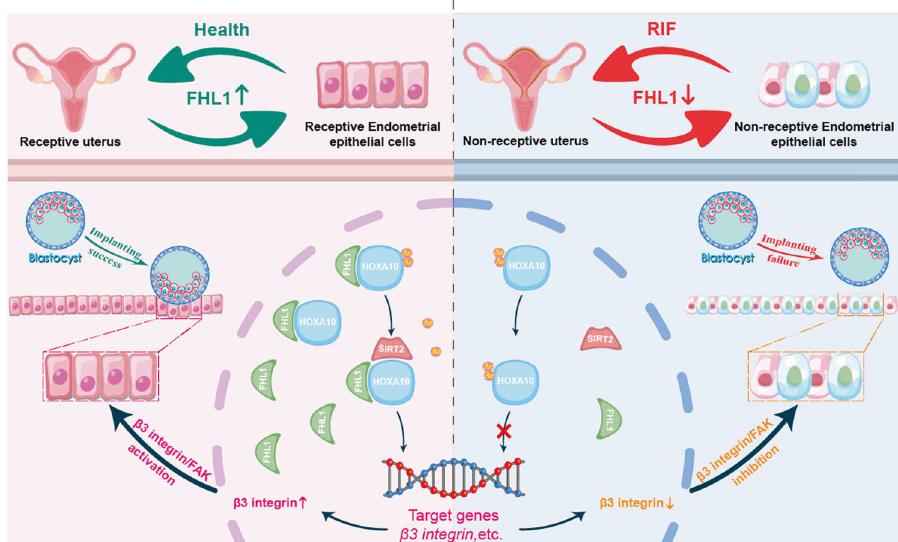
Fig. 8 Schematic diagram of the role of FHL1-mediated HOXA10 deacetylation in the regulation of blastocyst epithelial adhesion in RIF patients and fertile controls. In endometrial epithelial cells, FHL1 increases HOXA10 deacetylation by promoting the interaction of SIRT2 and HOXA10, thereby enhancing HOXA10 target gene transcription and downstream pathway activation. This role of FHL1 in the endometrium involves the establishment of endometrial receptivity and the failure of blastocyst epithelial adhesion in RIF